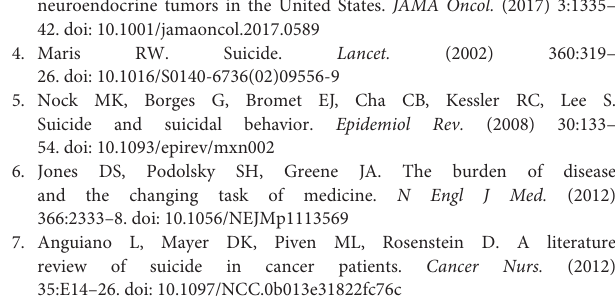
Supplementary Figure 1 | The performance of predictive factors to distinguish between suicide patients from non-suicide patients. The receiver operating characteristic (ROC) curves, the area under the curve (AUC), and the confidence interval (CI) suggest that age (A) , gender (B) , chemotherapy (C) , surgery (D) , and stage (E) could significantly distinguish suicide patients from non-suicide patients, however, race (F) , marital status (G) , and grade (H) did not have this ability to discriminate. Supplementary Table 1 | Mortality in patients dead from suicide, non-suicide, and all